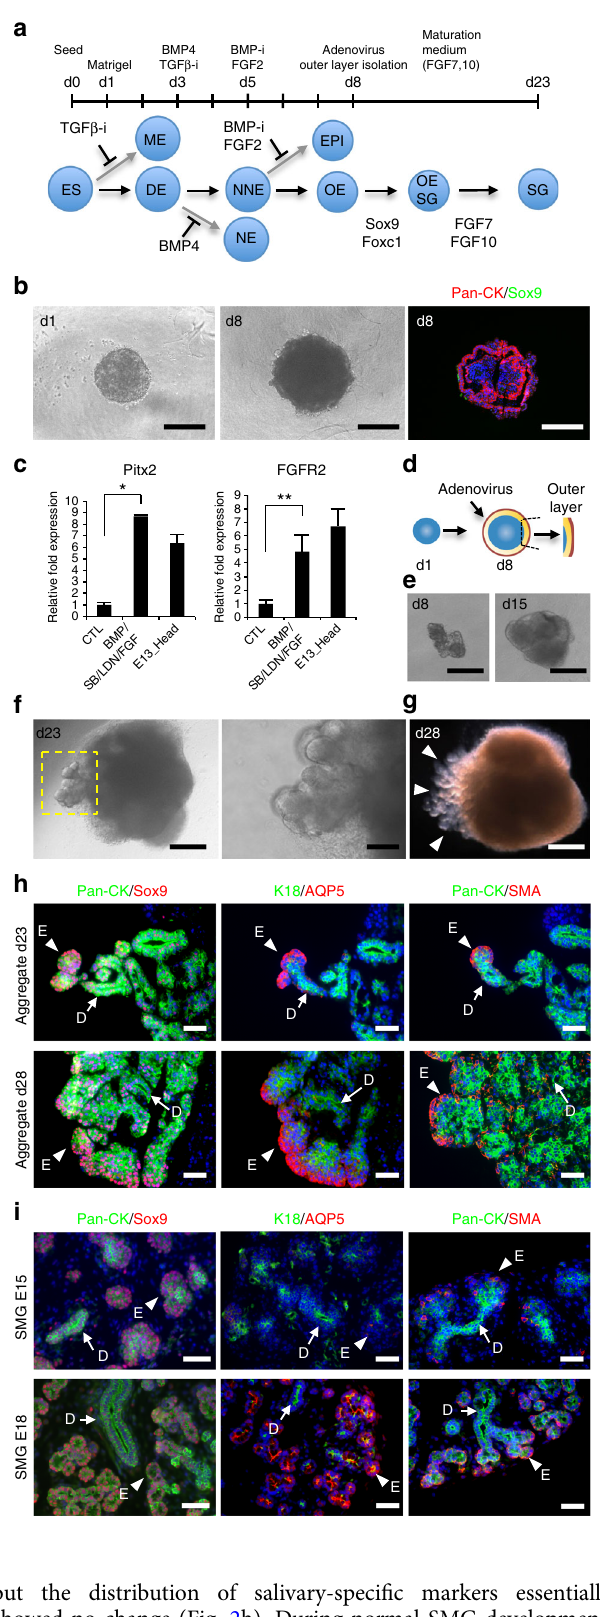
but the distribution of salivary-speci fi c markers essentially showed no change (Fig. 2h). During normal SMG development, as previously reported, AQP5 + signals were observed in the cytosol and basolateral membrane of the end bud cells of the E18.5 SMG (Fig. 2i), whereas these signals accumulated at the apical membrane surface of end bud cells of the E19 SMG 38 .